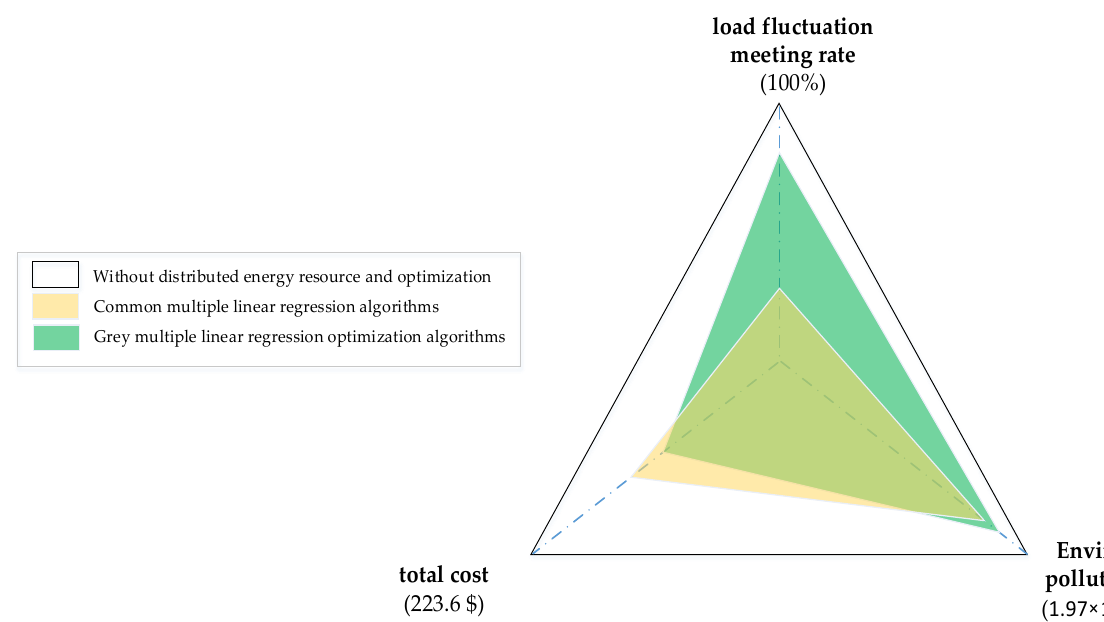
Figure 19. The running results of three algorithms. Table 4. A comparison of the performances of different methods.